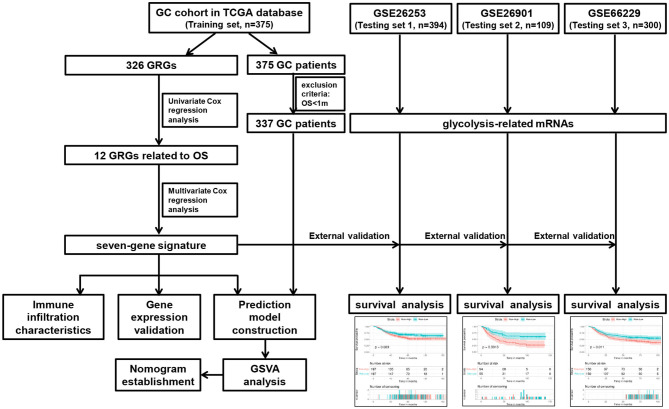
Flow chart of the systematic identification and comprehensive validation of the seven GRG signature in GC. GC, gastric cancer; TCGA, The Cancer Genome Atlas; GSE, Gene Expression Omnibus Series; OS, overall survival; GRGs, glycolysis-related genes.